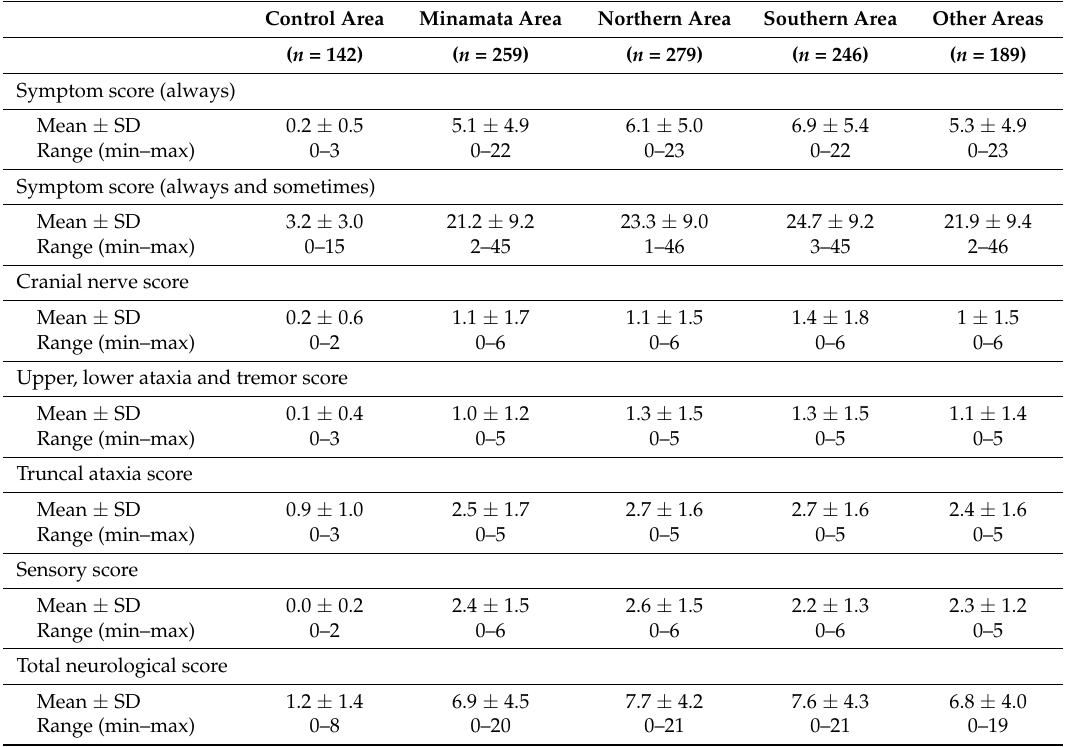
Table 9. Score of signs and symptoms in each area ( n = 1115).